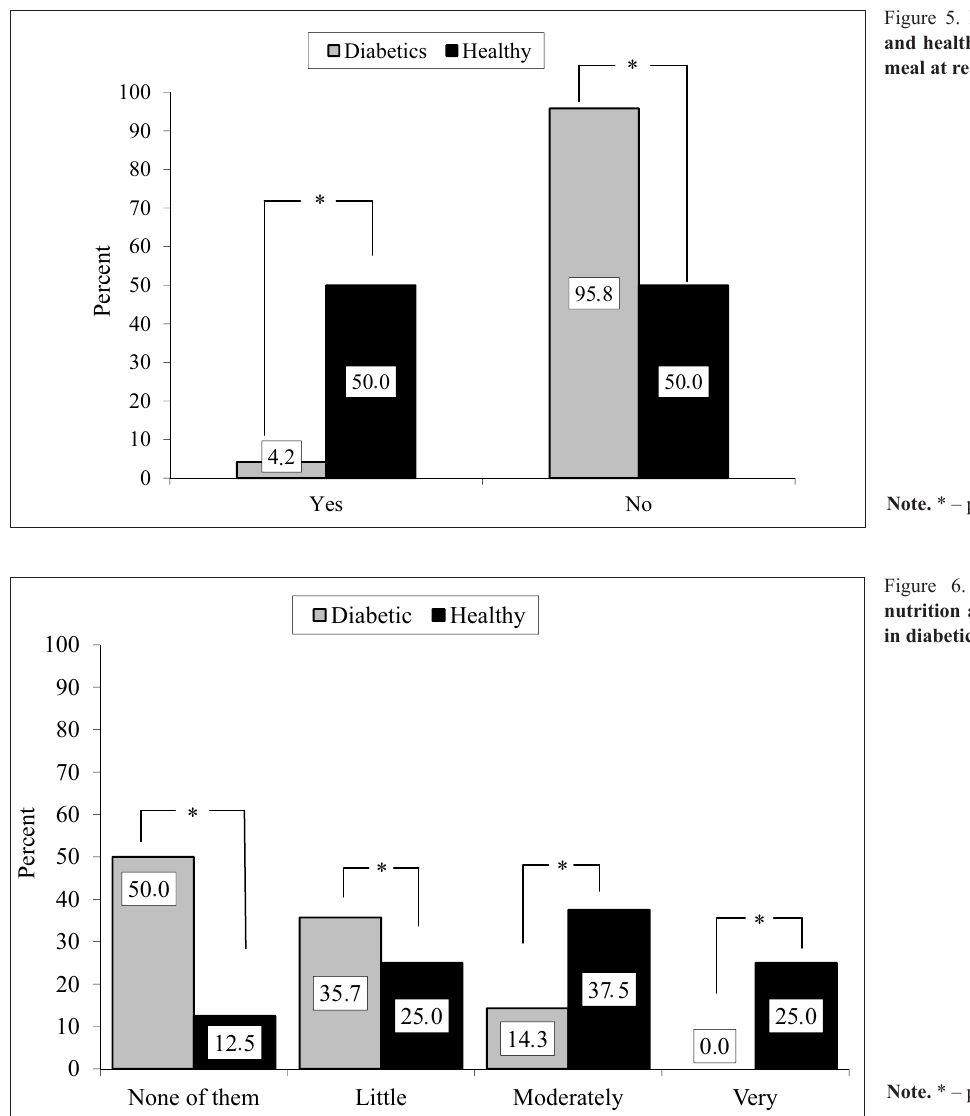
Figure 4. Structure of fat use by diabetic and young women